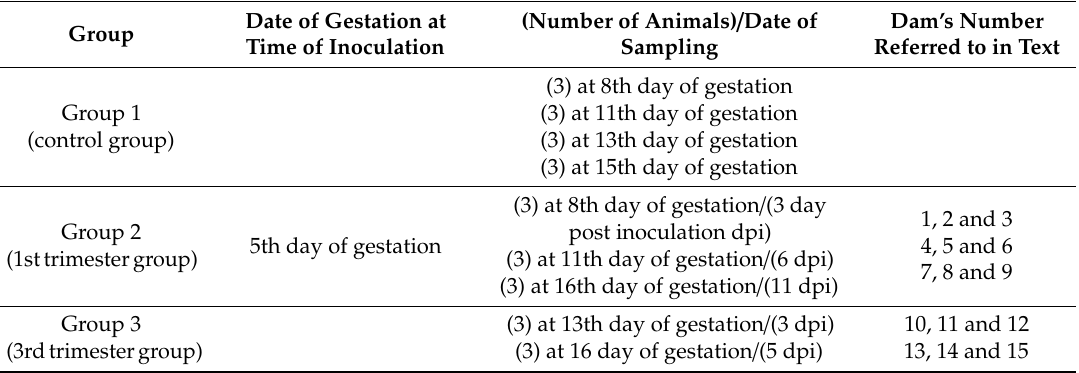
Table 1. Experimental